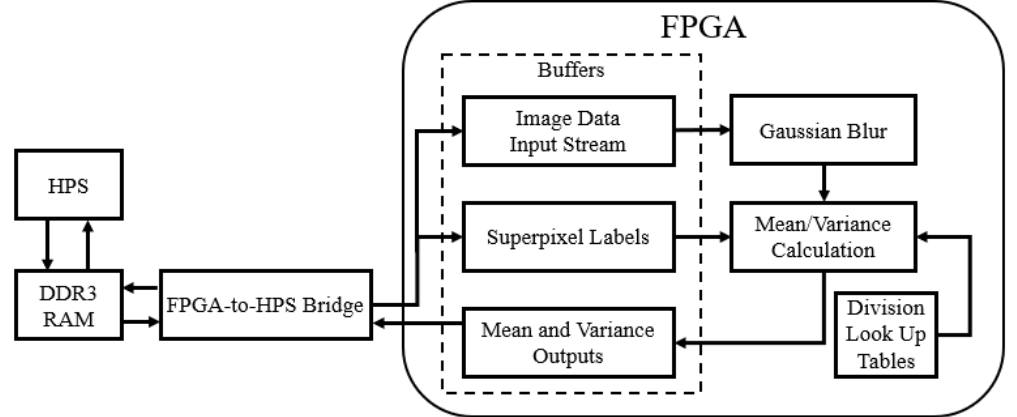
Figure 5. Top-level architectural diagram of the hardware partition, with arrows representing data